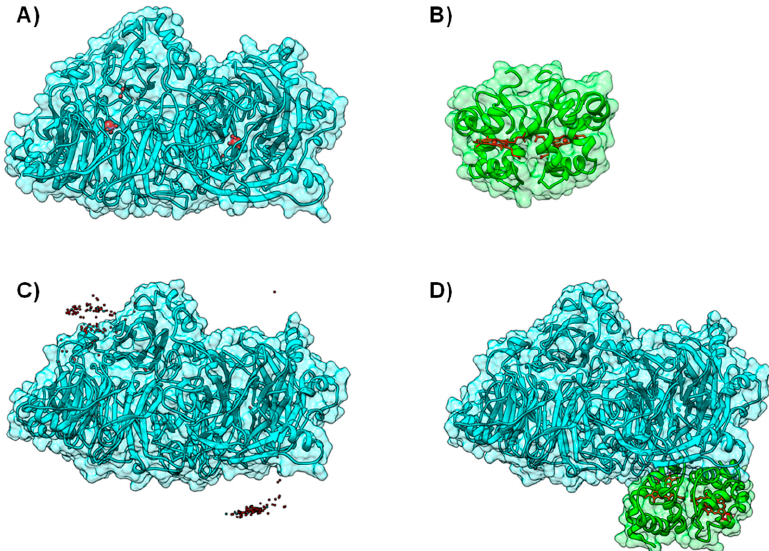
Figure 5. Electron transfer complex between Nitrous Oxide Reductase and cytochrome c 552 from Marinobacter hydrocarbonoclasticus . Panels ( A ) and ( B ) depict the backbone structure of Marinobacter hydrocarbonoclasticus N 2 OR and cytochrome c 552 , respectively. Metal centers (CuA and CuZ center for N 2 OR and heme for cytochrome c 552 ) are represented in red; Panel ( C ) 200 top docking solutions ranked by hydrophobic score of N 2 OR—cytochrome c 552 electron transfer complex. The iron atom in the heme of each cytochrome c 552 putative docking position is represented as a red sphere; Panel ( D ) A top model structure for the electron transfer complex obtained by BiGGER is represented (probe 2, Table S1 [54]). N 2 OR is colored cyan and cytochrome c 552 is colored green. Figure prepared using UCSF Chimera